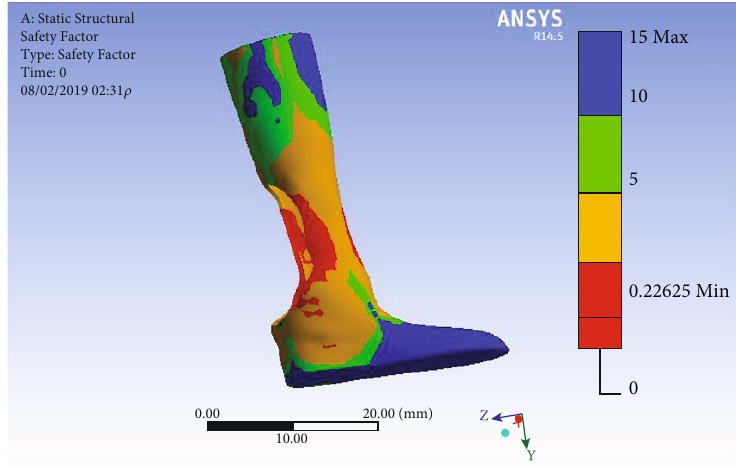
Figure 16: Group C fatigue factor of safety.